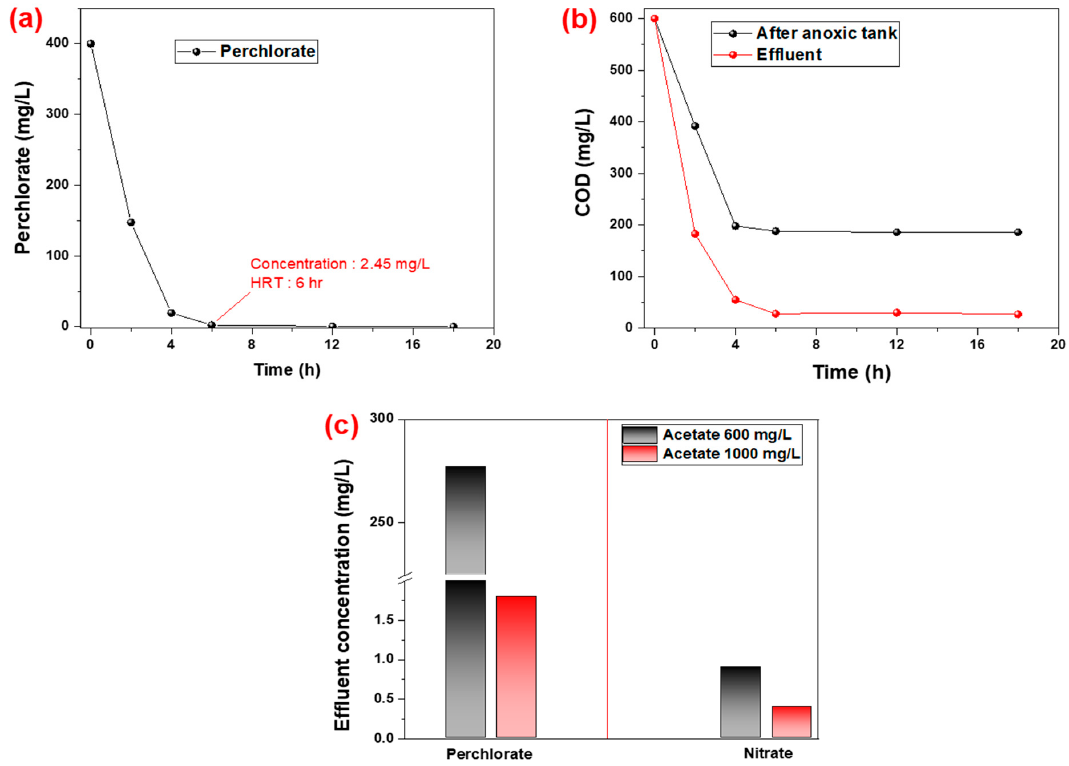
Figure 4. Lab scale operation of activated sludge treatment for perchlorate biodegradation by mixed microbial culture. ( a ): HRT optimization at a biomass concentration of 1000 mg MLVSS/L; ( b ): COD variation from the reactor while optimizing the HRT; ( c ): impact of acetate concentration on perchlorate and nitrate reduction at 6 h HRT.